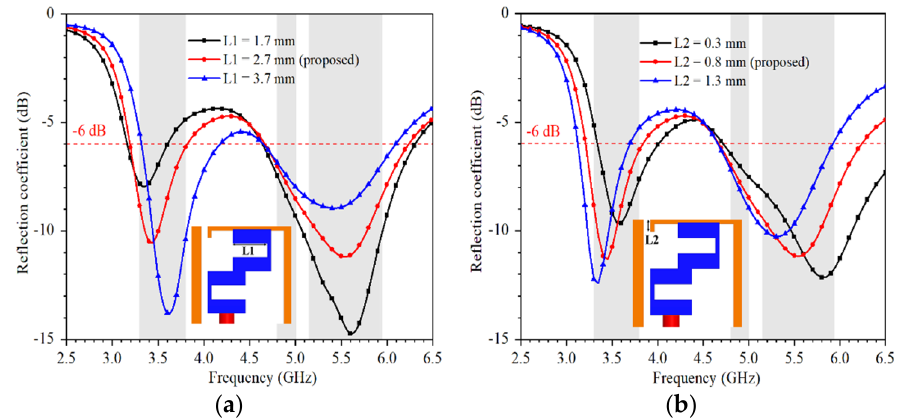
Figure 4. The simulated reflection coefficient as a function of ( a ) L1, ( b ) L2.